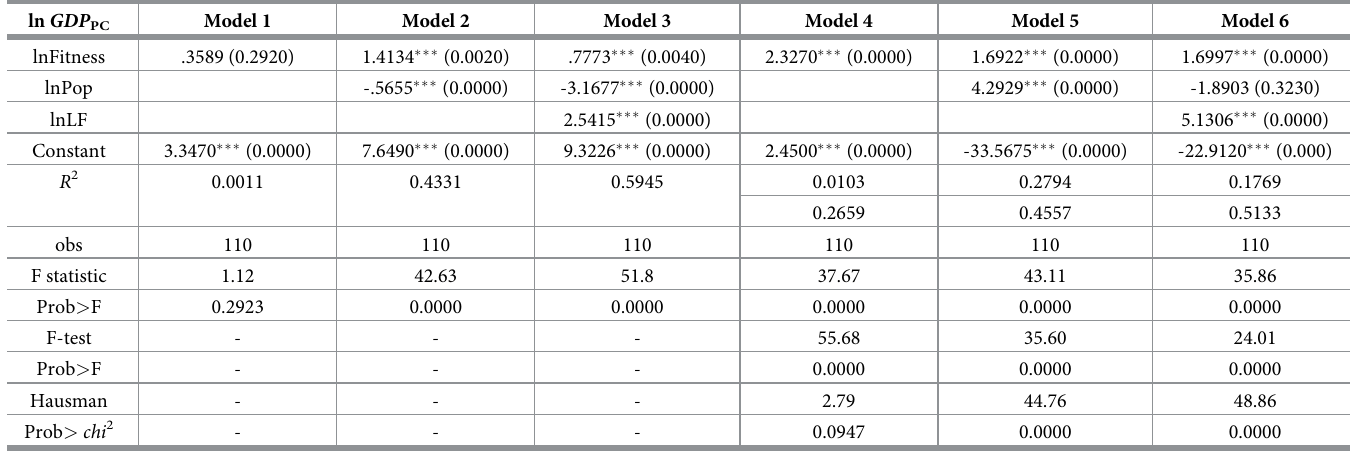
Table 1. Regression results of the mixed regression model and fixed effect model of economic fitness for GDP prediction after SDC-HMM noise